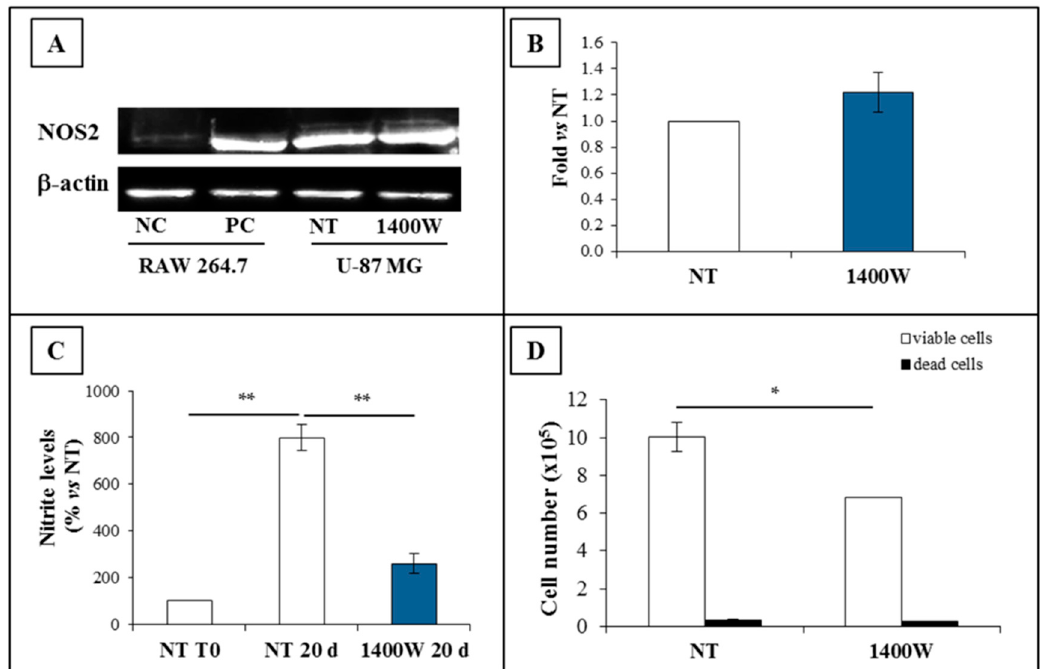
Figure 5. NOS2 protein expression and activity in U-87 MG-generated neurospheres. ( A ) Representative Western blot of NOS2 and β -actin. U-87 MG neurospheres were incubated in the absence (not treated, NT) or presence of 1400W (100 μ M) daily added for 20 days. NC (negative control): untreated